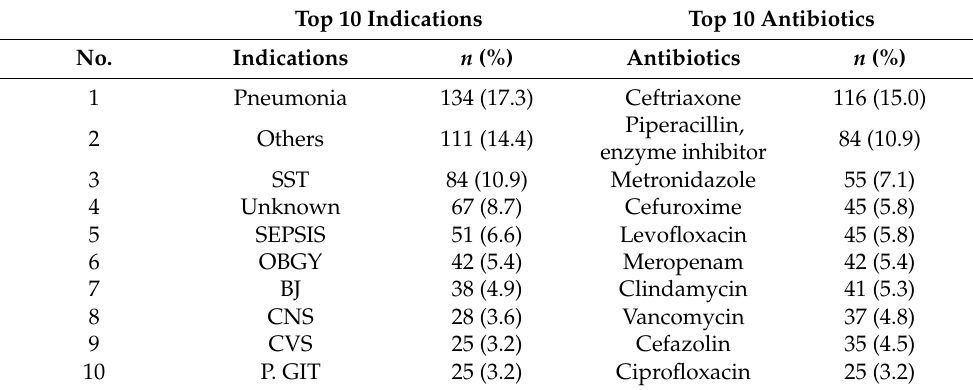
Table 3. Top 10 indications and antibiotics.